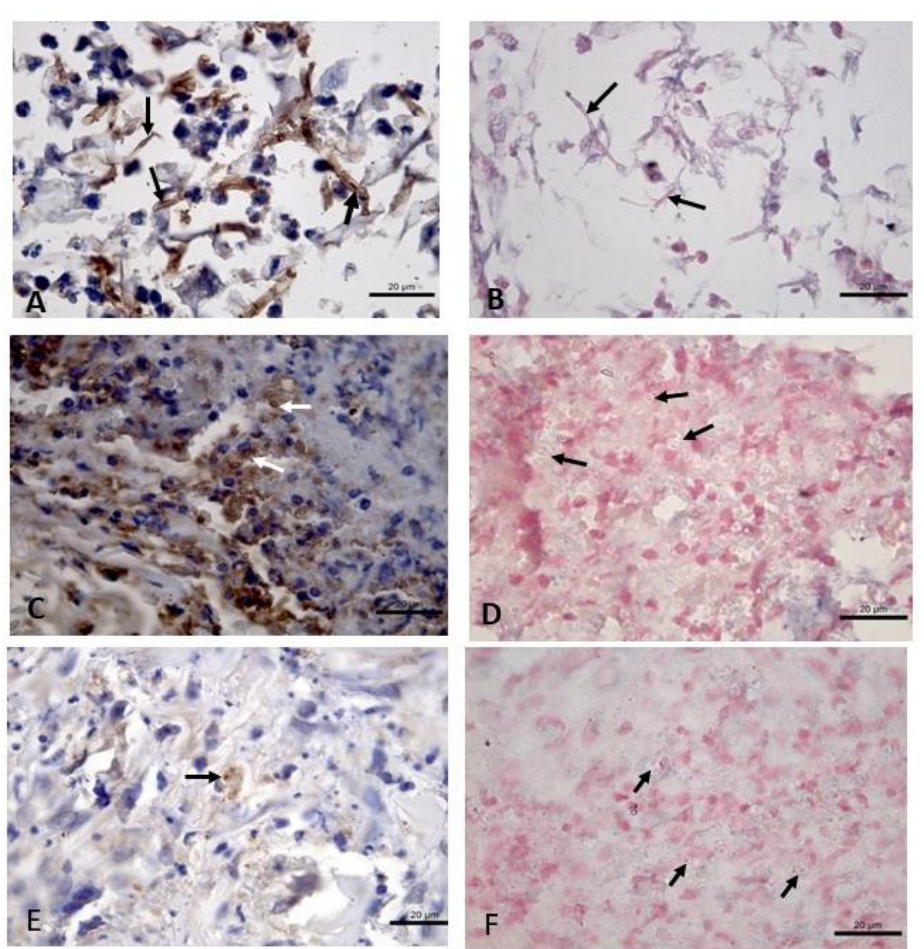
Figure 2. Cross-reaction evaluation by immunohistochemistry (IHC) using polyclonal rabbit anti- Leishmania sp. serum and cross-hybridization by colorimetric in situ hybridization (CISH) using a generic probe for Leishmania spp. in samples fixed in 10% formalin and paraffin-embedded of cutaneous lesions from fungal-infected patients. ( A ) Infected skin by Candida sp. Brown stained hyphae are observed (arrows). IHC, 100 × objective. ( B ) Infected skin by Candida sp. There was no staining of hyphae using the generic probe for Leishmania spp. (arrows). CISH, 100 × objective. ( C ) Infected skin by Sporothrix sp. Brown-stained yeasts are observed (arrows). IHC, 100 × objective. ( D ) Infected skin by Sporothrix sp. There was no staining of yeasts using the generic probe for Leishmania spp. (arrows). CISH, 100 × objective. ( E ) Infected skin by Histoplasma sp. showing brown-stained yeasts. (arrow). IHC, 100 × objective. ( F ) Infected skin by Histoplasma sp. There was no cross-staining using the generic probe for Leishmania spp. (arrows). CISH, 100 ×